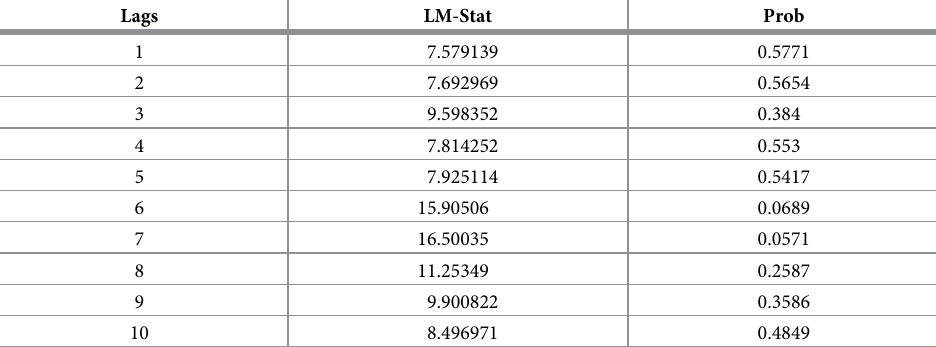
Table 7. Serial correlation LM test for Australian data when P = 4 (proposed model).